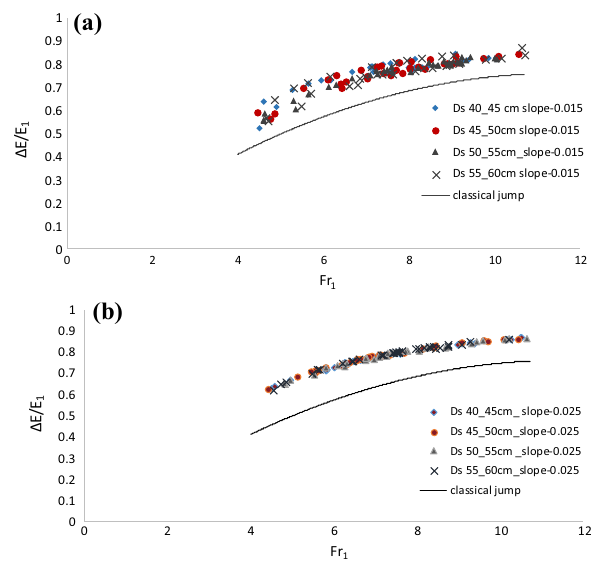
Fig. 6 The relative energy dissipation E bed slope with double screens with different distances a S 0 = 0.015 b S 0 = 0.025)